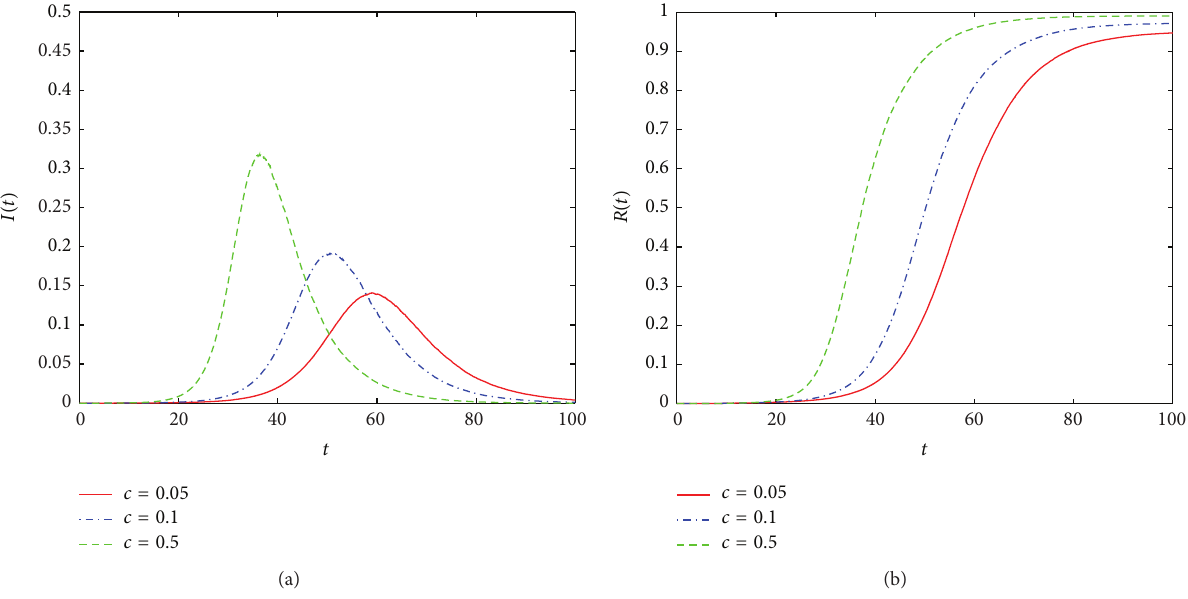
Figure 6: Density of spreaders and stiflers on random networks.